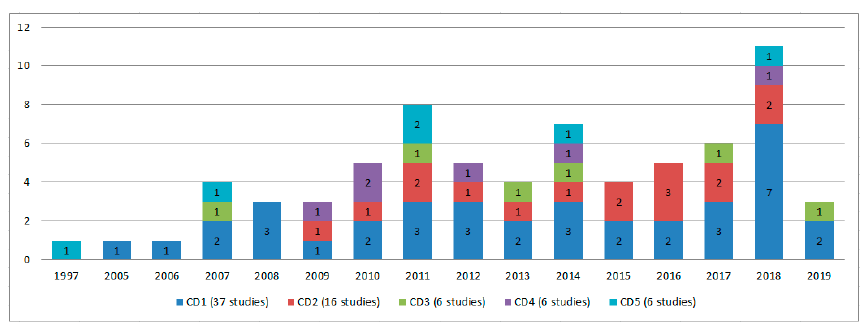
Figure 4. Quantitative distribution of studies by application domain category over time period.